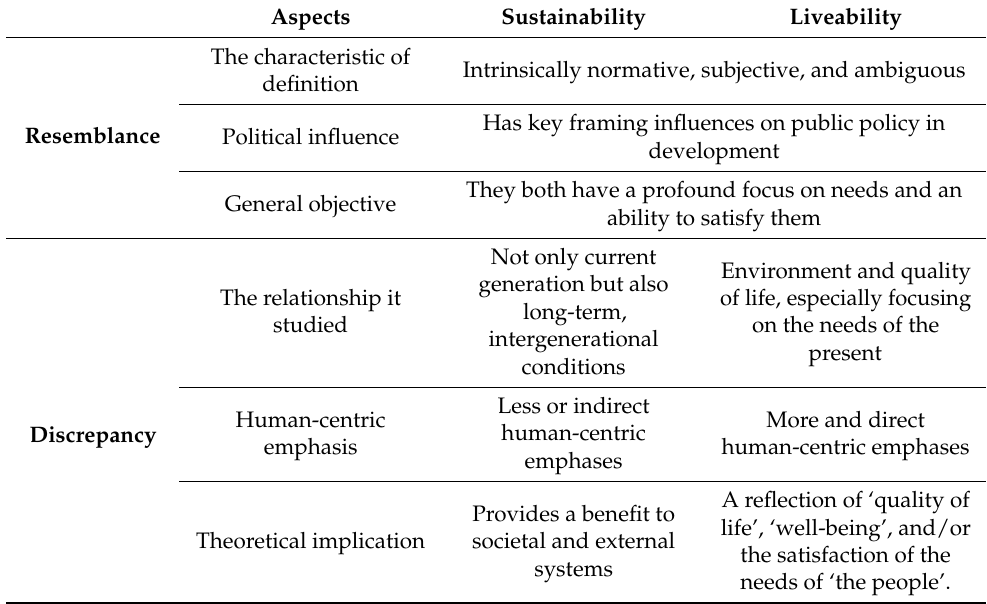
Table 1. Resemblances and discrepancies between sustainability and liveability (source: